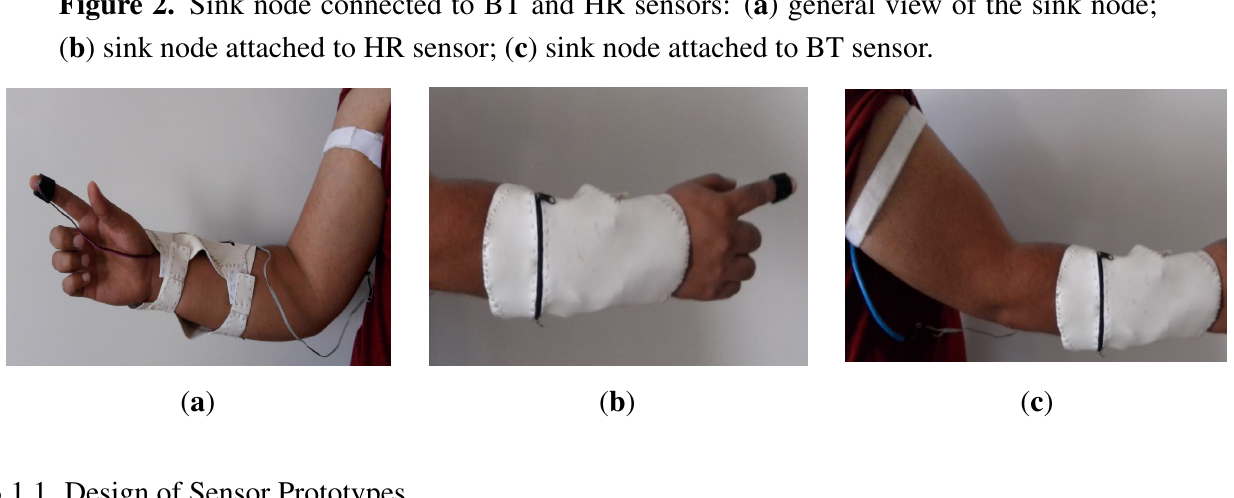
Figure 2. Sink node connected to BT and HR sensors: ( a ) general view of the sink